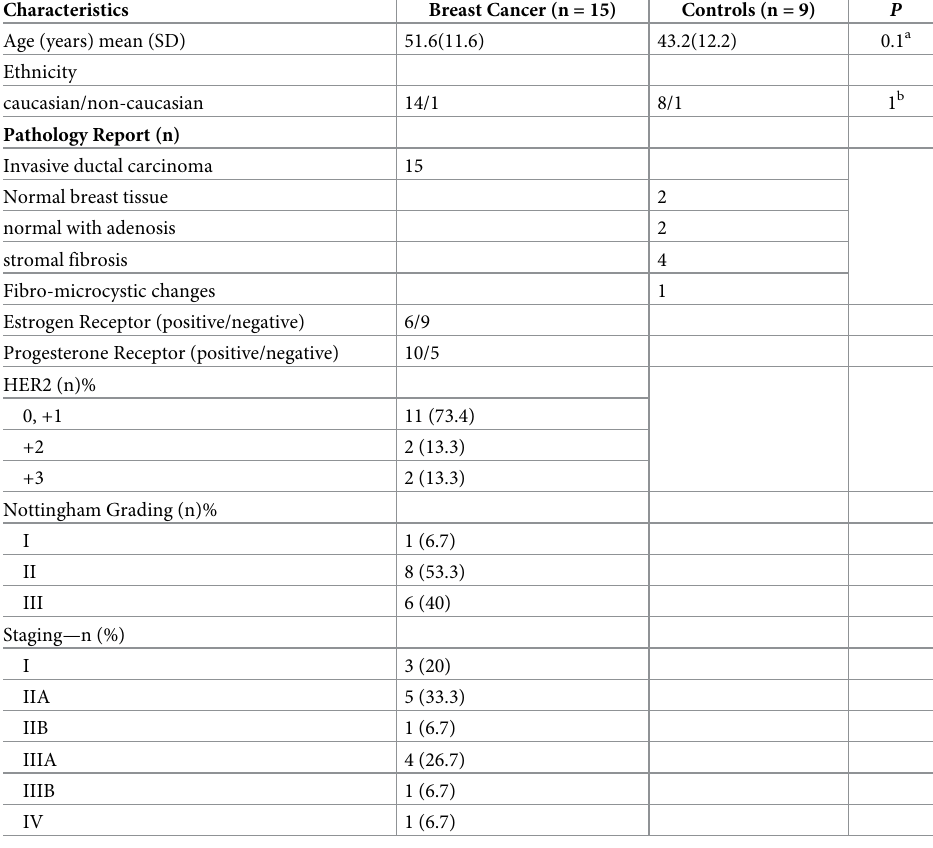
Table 1. Characteristics of the studied